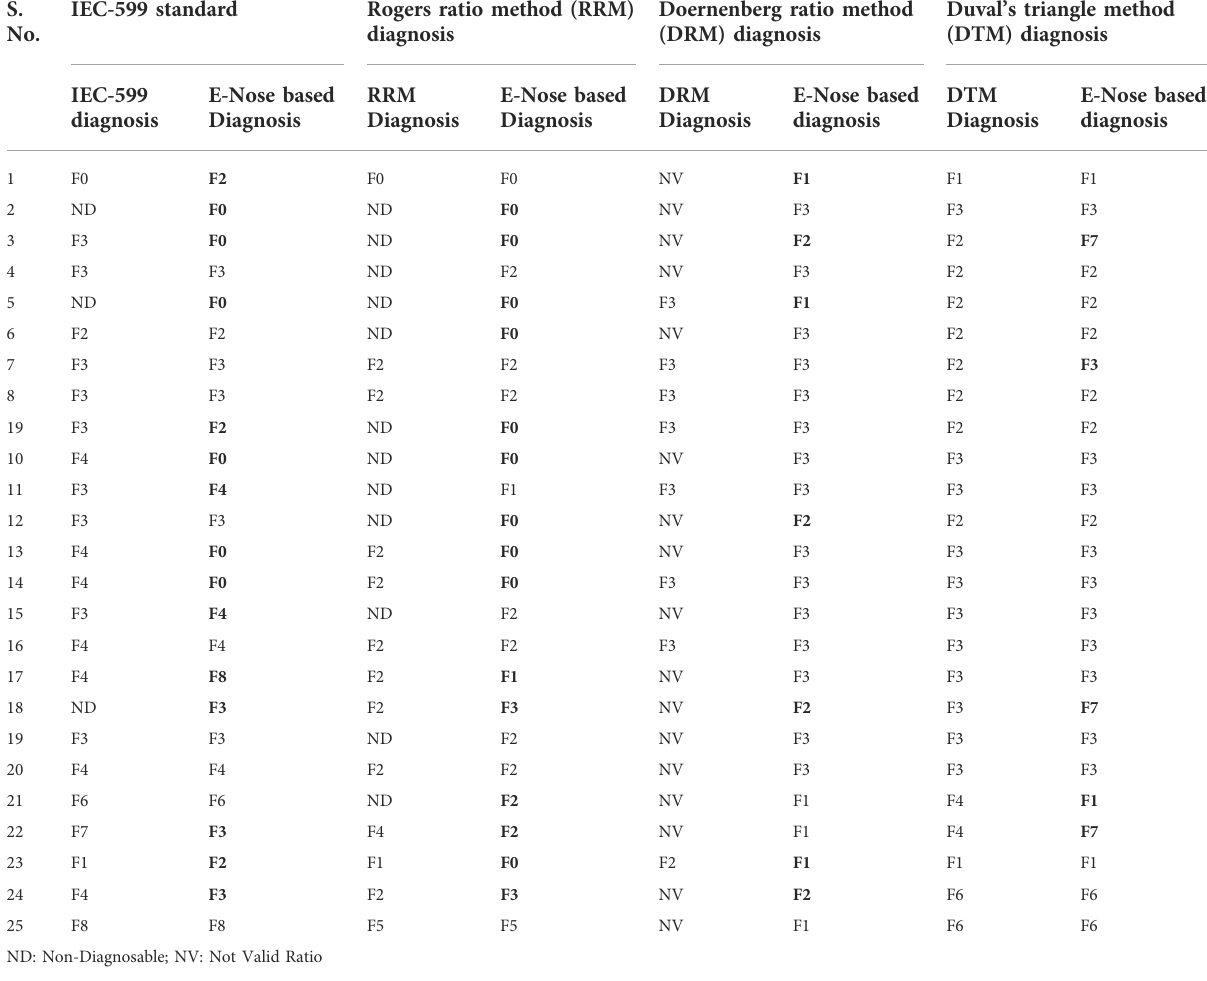
TABLE 4 Transformer fault diagnosis results using the E-Nose setup. S.